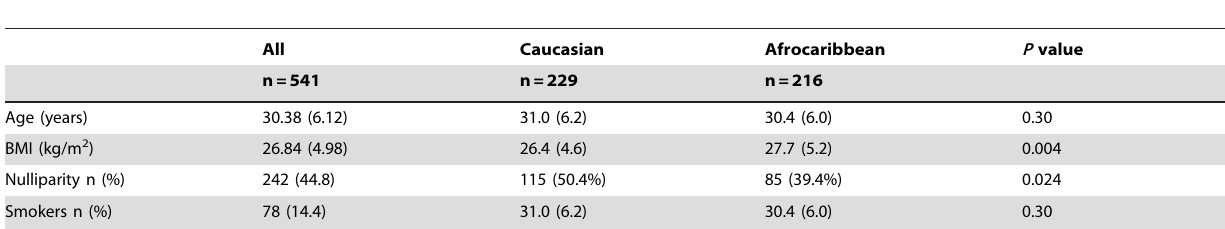
Table 1. Baseline characteristics of the study groups.